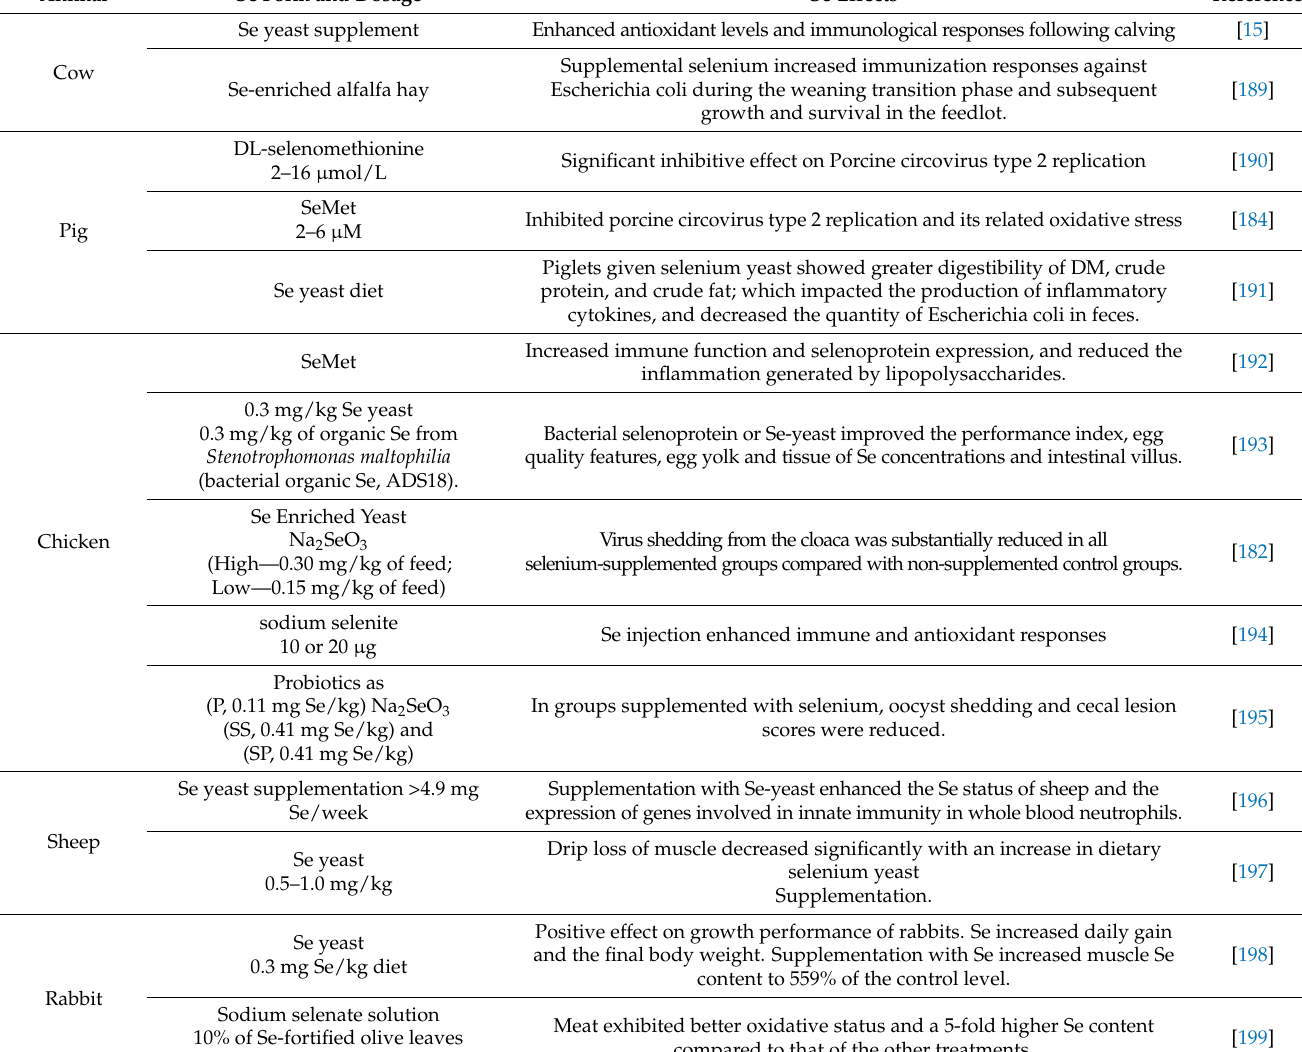
Table 2. Se biofortification effects in